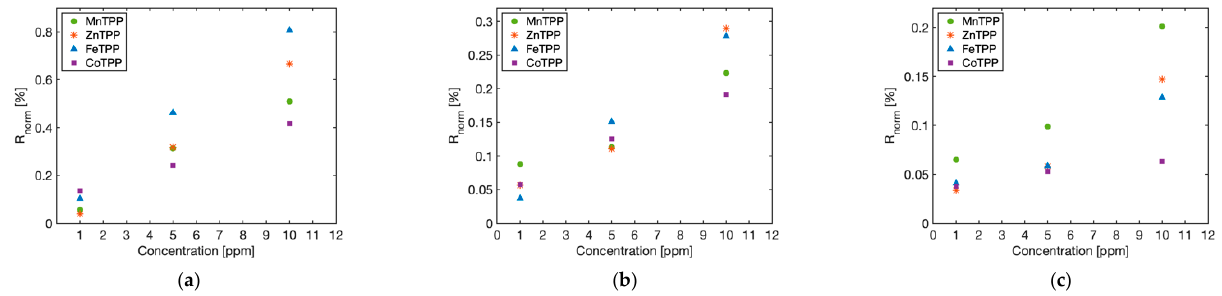
Figure 6. Sensing responses of the RGO–metalloporphyrin-sensor array were plotted as a function of different concentrations of ( a ) ammonia, ( b ) acetone, and ( c ) isopropanol.